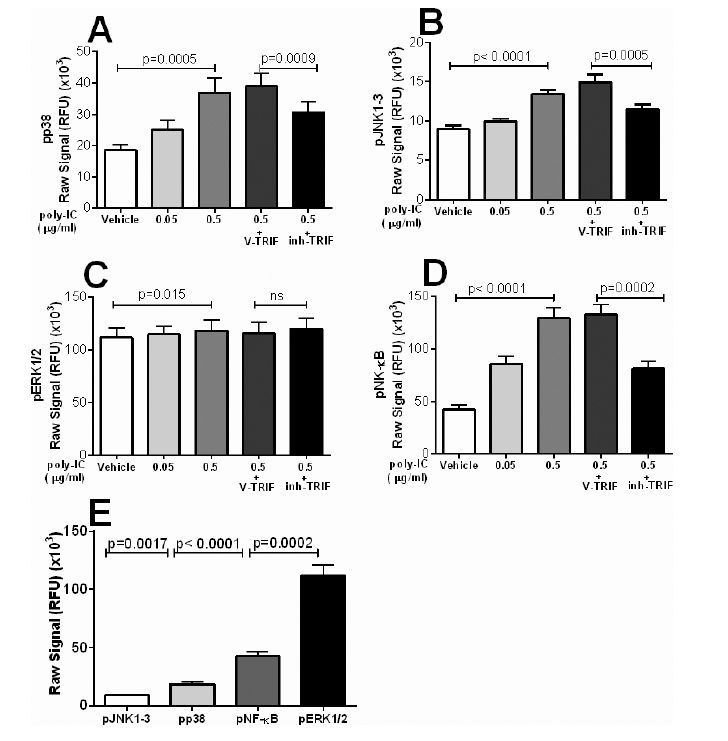
Figure 3. Stimulation with poly-IC induces phosphorylation of MAP kinases and NF- κ B and is inhibited by TRIF. Cells were preincubated with the TRIF inhibitor (ihh-TRIF) or vehicle (V-TRIF) (25 m mol/L for 5 h) and/or stimulated with poly-IC (0.05 m g/mL or 0.5 m g/mL) for another 1.5 h. Adherent cells were then lysed and the lysate used to measure phosphor- ylated levels of p38, JNK1–3, ERK1/2 and NF- κ B by phosphorTracer ELISA. Panels (n = 8) show relative fluorescence units (RFU) of (A) Phosphorylated (p) p38, (B) pJNK1–3, (C) pERK1–3, (D) pNF- κ B and (E) comparative levels for the different molecules. The p values indicated are according to Student paired t test and a p < 0.05 is considered